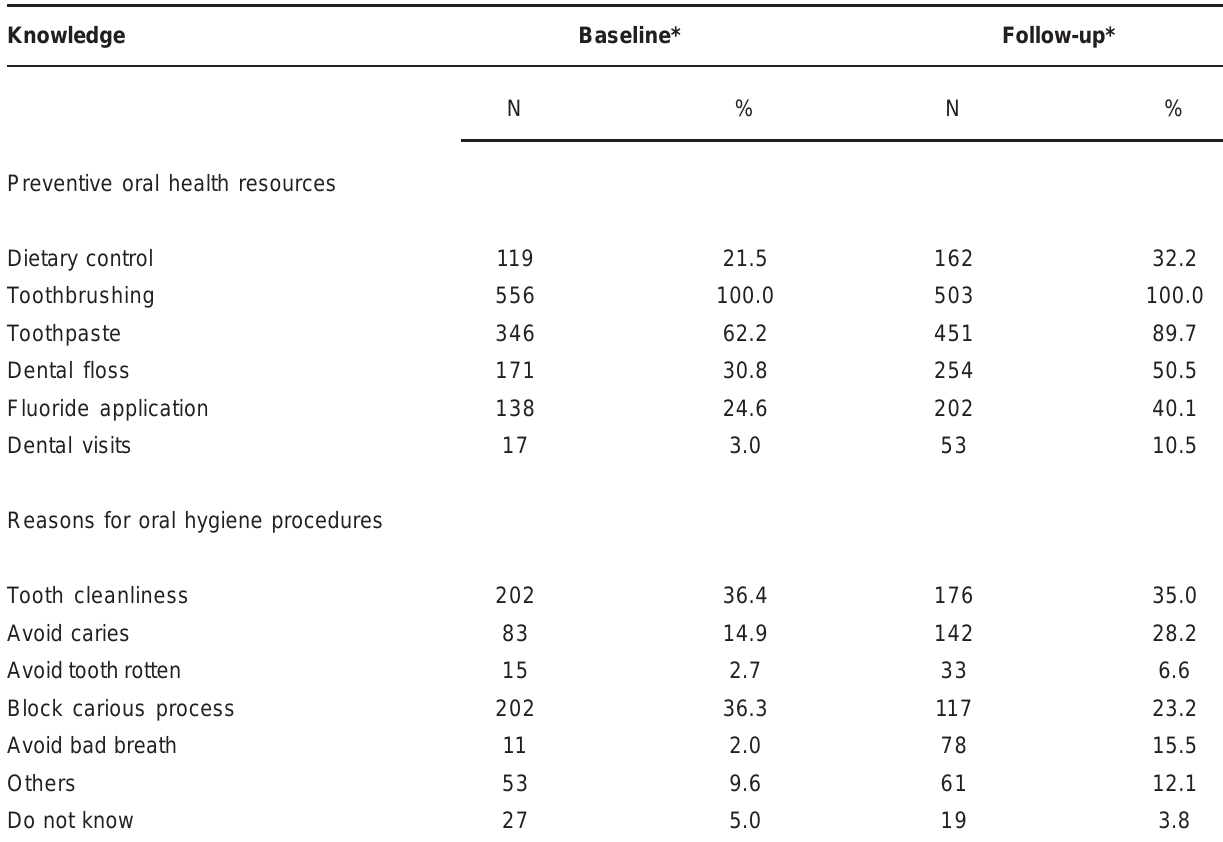
TABLE 2 - Knowledge about oral health care among children and adolescents of public schools in Maringa, Brazil, at baseline (N=556) and at follow-up interviews